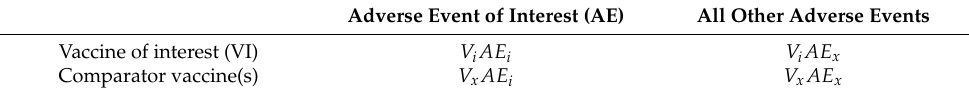
Table 8. Table (2 × 2) for the computation of the proportional reporting ratio (PRR). Adverse Event of Interest (AE)